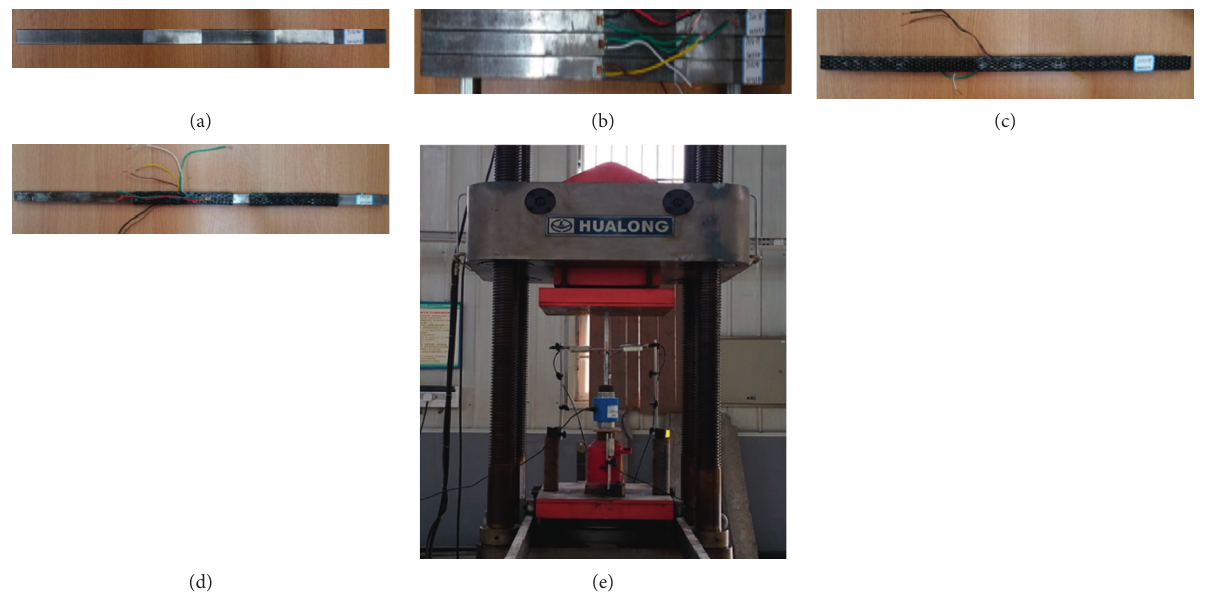
Figure 1: Experiment setup. (a) Grinding the damage area, (b) pasting G 1 and G 2 strain gauges, (c) pasting CFRP, (d) pasting B 1 and B 2 strain gauges, and (e) loading